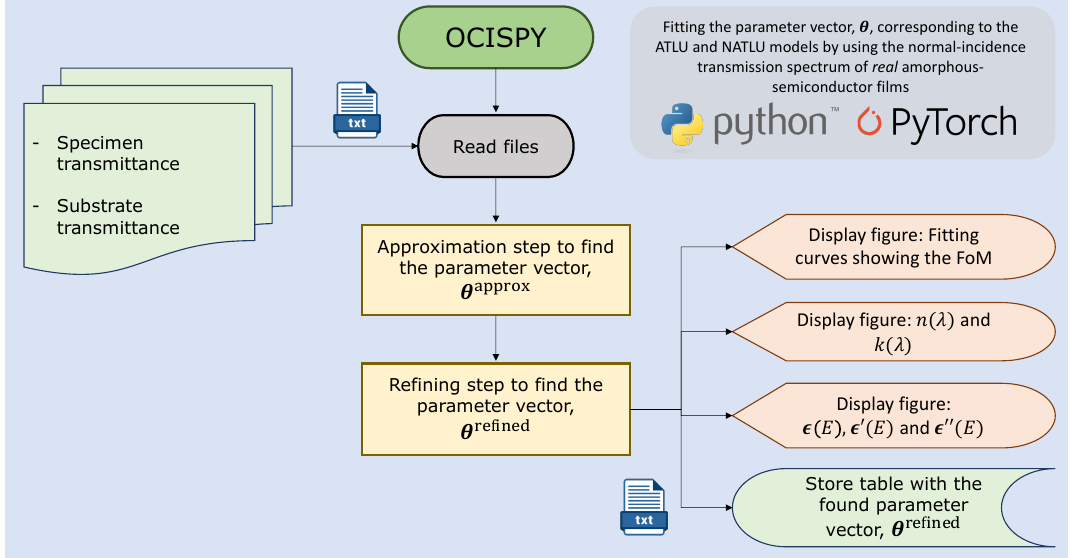
Figure 2. A very simplified flowchart corresponding to the optimization algorithm for the compre- hensive optical characterization of amorphous-semiconductor thin layers. This specific algorithm is implemented in the Python-based computer program, OCISPY, presented and employed in this work. θ stands for the parameter vector introduced in the program. It very accurately solves the problem of extracting the optical properties, together with the average layer thickness, ¯ d , and the wedging parameter, ∆ d , of non-crystalline-semiconductor thin